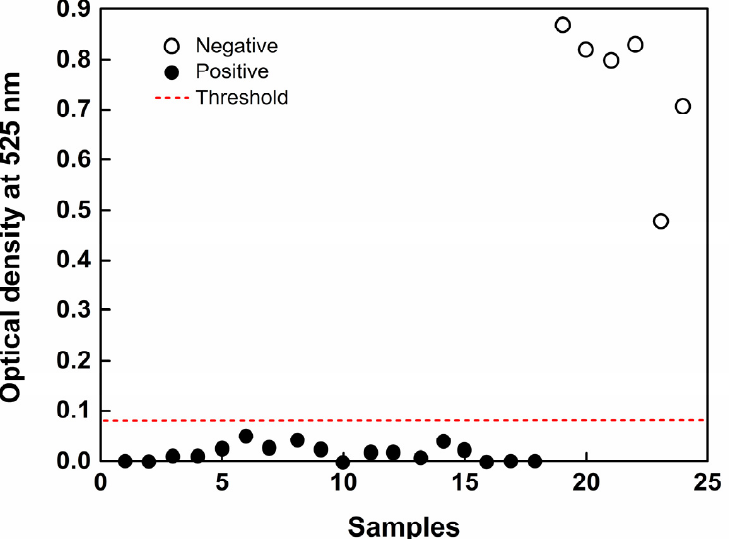
Figure 8. Absorbance values for food samples infected (positive) or not infected (negative) were recorded using a plate reader. A threshold line (red line) was set that maximized the assay’s discrimination performance.